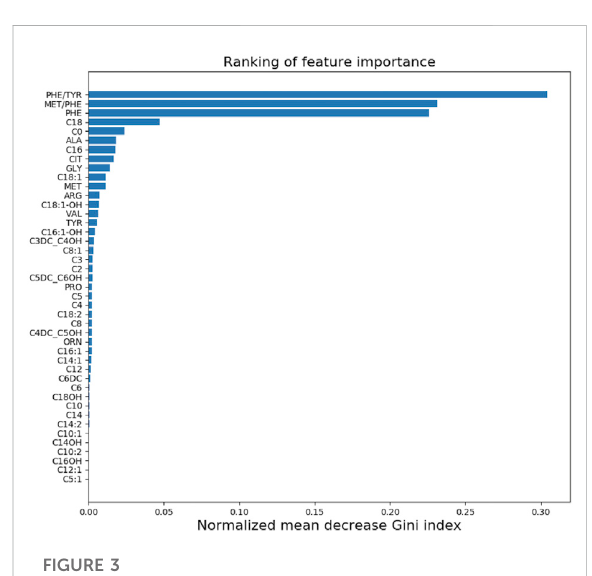
FIGURE 3 The ranking of 43 small molecule metabolites importance in our